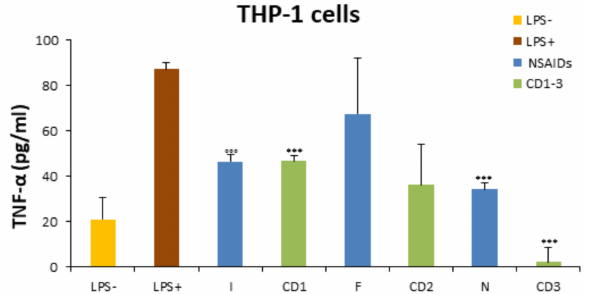
Figure 4. Reduction in TNF- α levels by CD1-3 in THP1-cells. TNF- α secretion was determined by ELISA assay in LPS-treated-THP-1 cells (100 ng/mL), NSAID (I = Ibuprofen, F = Flurbiprofen, N = Naproxen), or CD1-3 derivates (25 µ M) for 24 h. All values are reported as the mean ± SD. ◦◦◦ p < 0.001 compared with the LPS − group, *** p < 0.001 compared with the LPS +